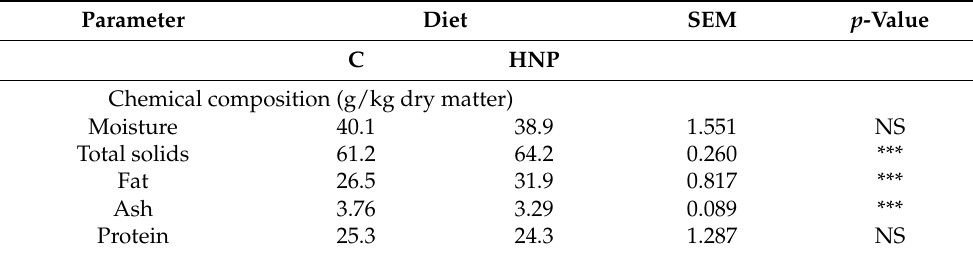
Table 2. Chemical composition of cheeses produced with milk of ewes fed with Control (C) or Hazelnut Peels (HNP) diets.